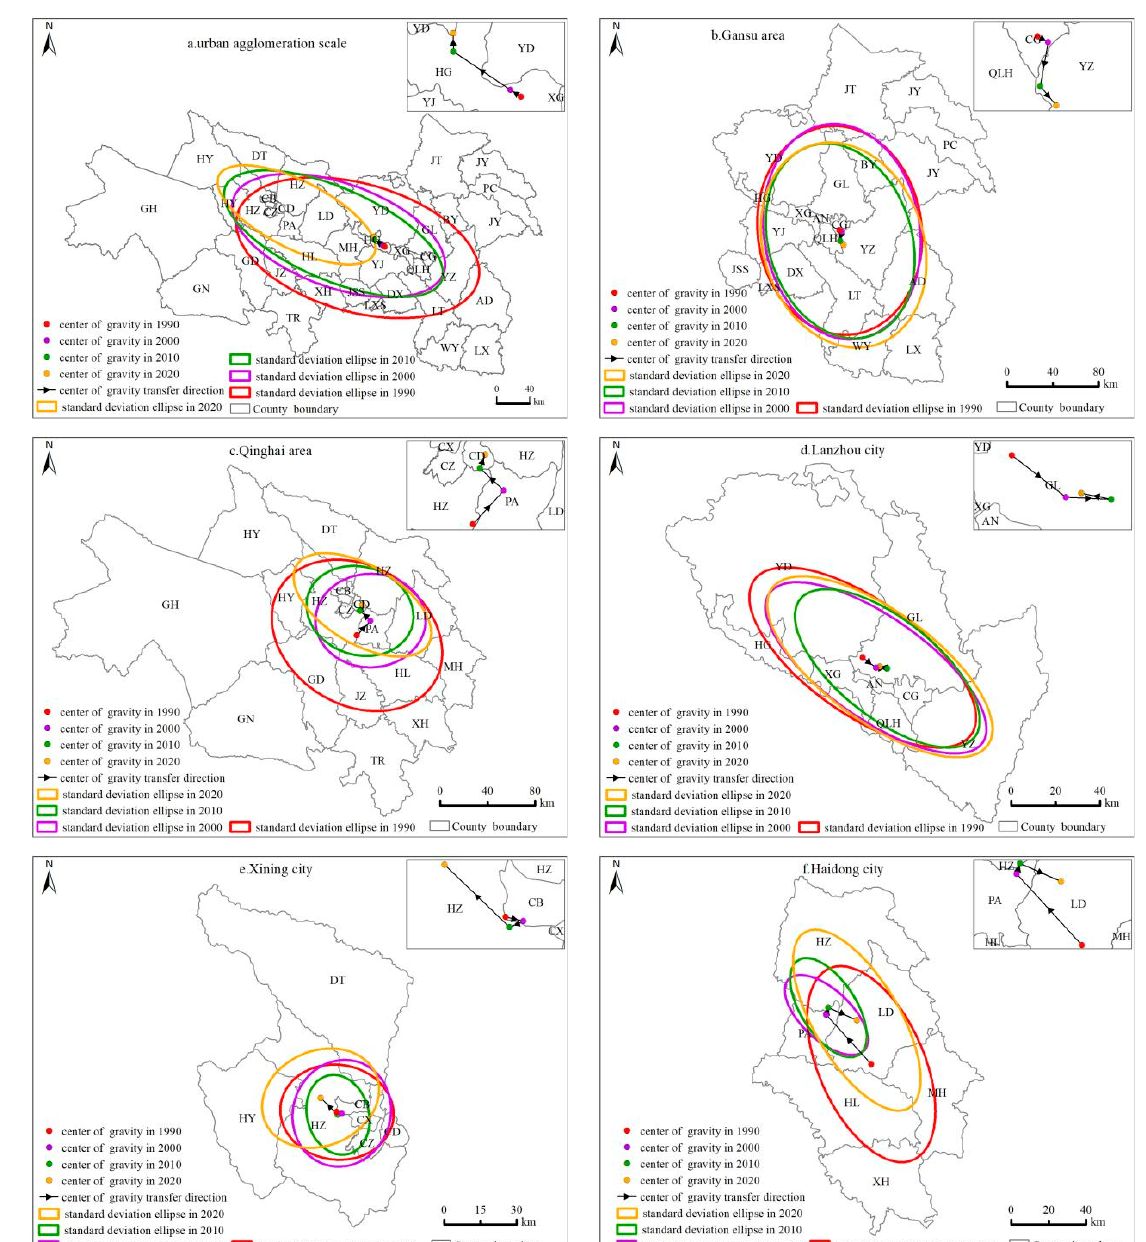
Figure 4. Distributions of the central shifts of construction land above the city level in the study area from 1990 to